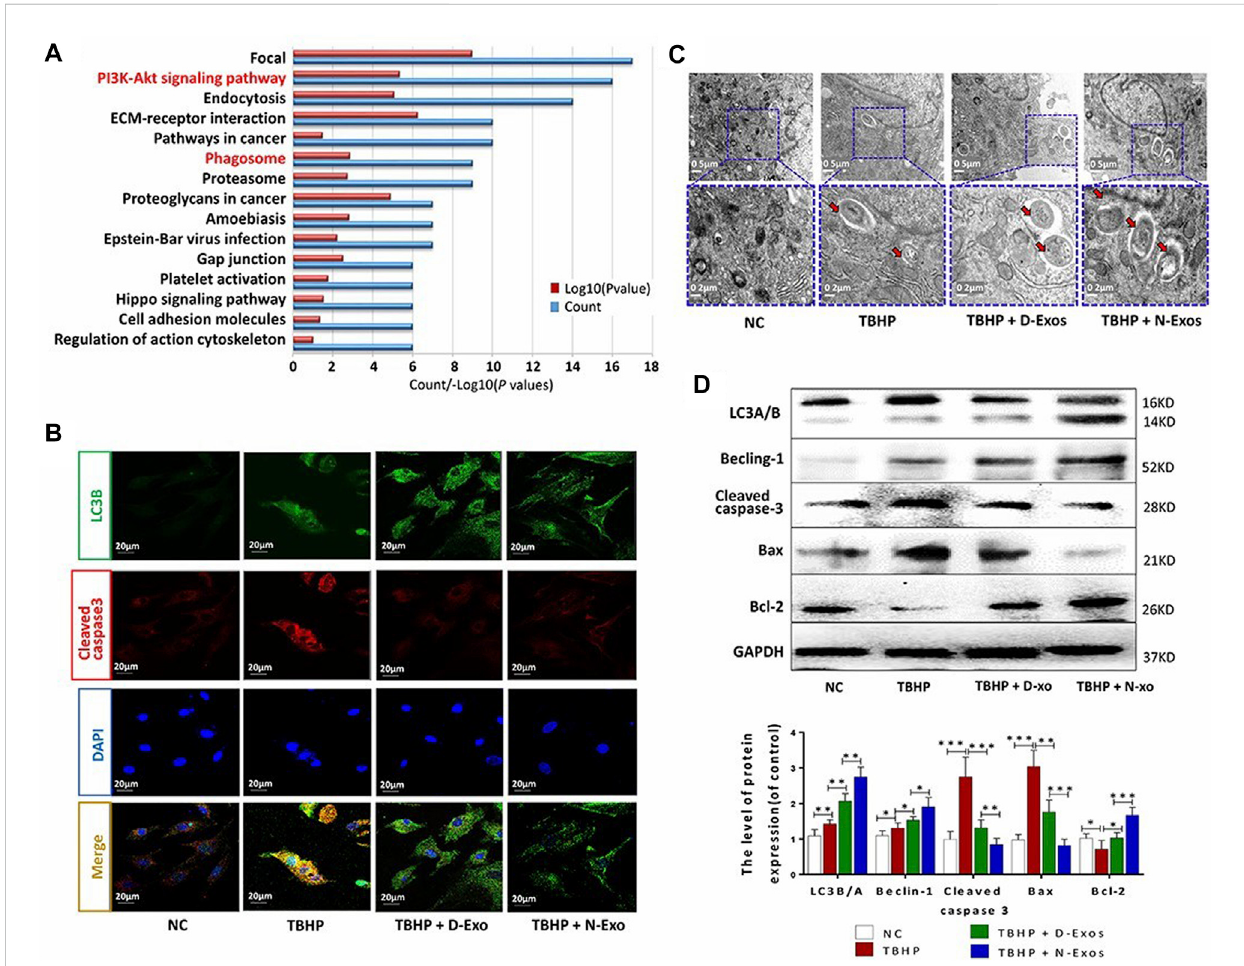
FIGURE 3 Analysis of the enrichment of differential proteins in exosomes derived from normal CEP stem cells (N-exons) and exosomes derived from degenerate CEP stem cells (D-exons) using KEGG (A) Immuno fl uorescence images of LC3-B and cleaved caspase-3 in NP cells (B) Autophagosomes in each group were observed by transmission electron microscopy (C) Western blots and quantitative analysis of LC3B/A, Beclin-1, cleaved caspase-3, Bax, andBcl-2ineachgroup. (D) “ * ” p < 0.05, “ ** ” p < 0.01 and “ *** ” p < 0.001. Reproduced withpermissionfrom apreviouspublication(Luo